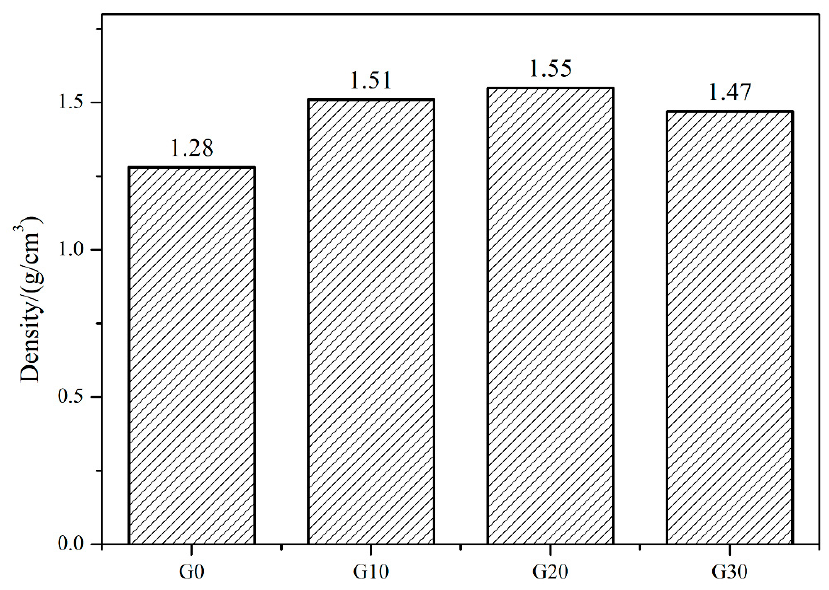
Figure 4. The density of G0, G10, G20 and